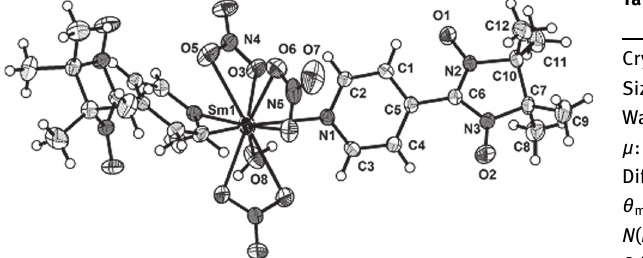
Table 1: Data collection and handling.